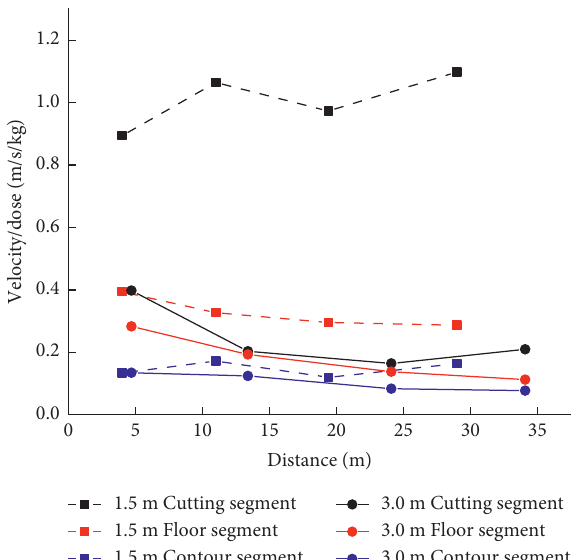
Figure 5: Comparison of the ratios of the vibration velocity to single-segment explosive charge of typical blasting segments with different footage conditions ahead of the corresponding blasting